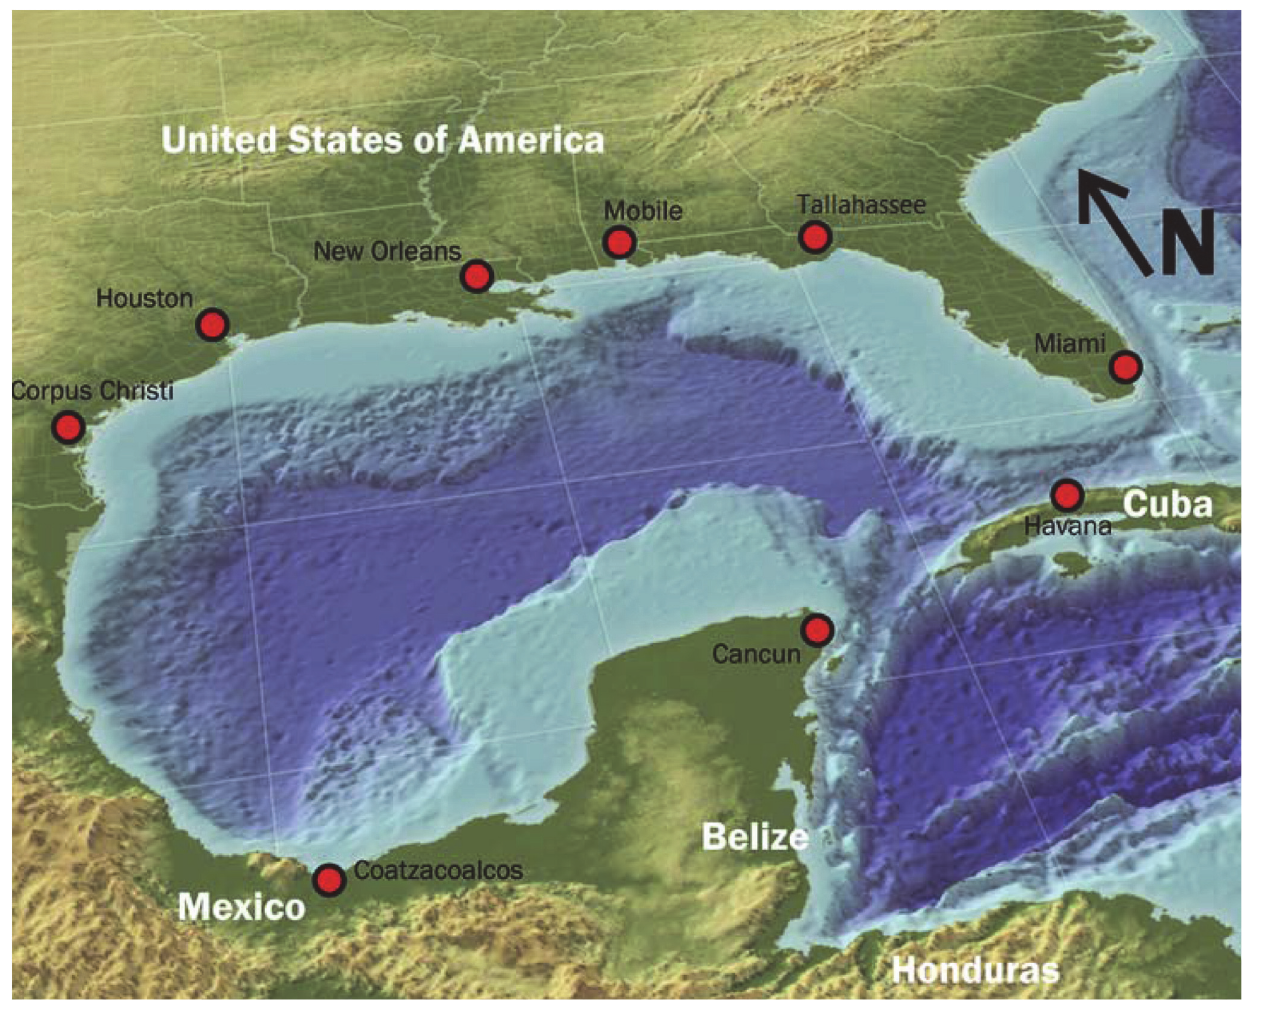
Fig 1. The Gulf of Mexico. http://en.wikipedia.org/wiki/Gulf_of_Mexico#mediaviewer/File:Fixed_gulf_map.png